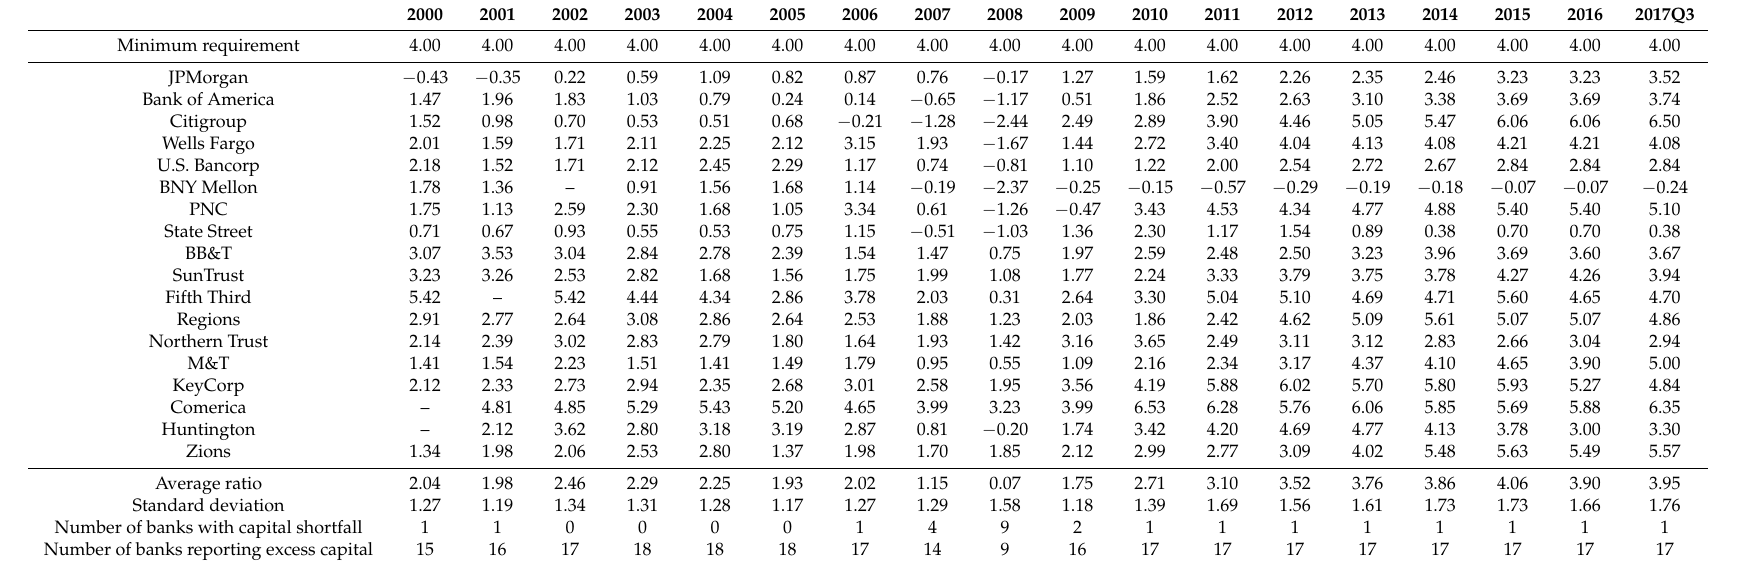
Table A5. Actual Tangible Common Equity Ratio Minus Assumed Required Minimum Tangible Common Equity Ratio of 4